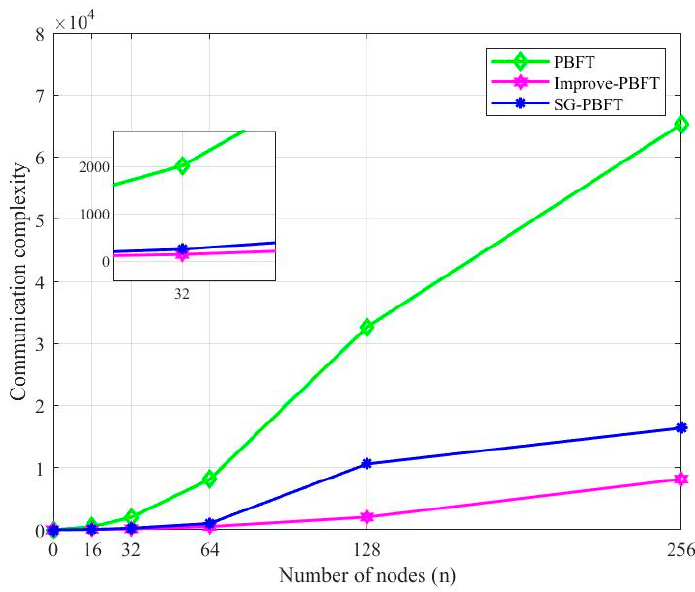
Figure 6. Comparison of communication complexity with different numbers of nodes.